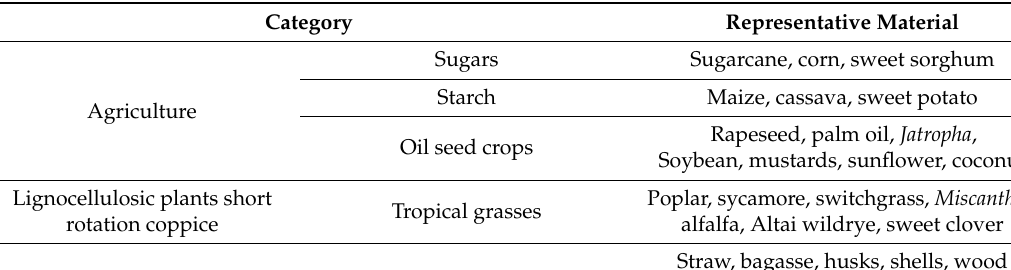
Table 1. Biomass type according to